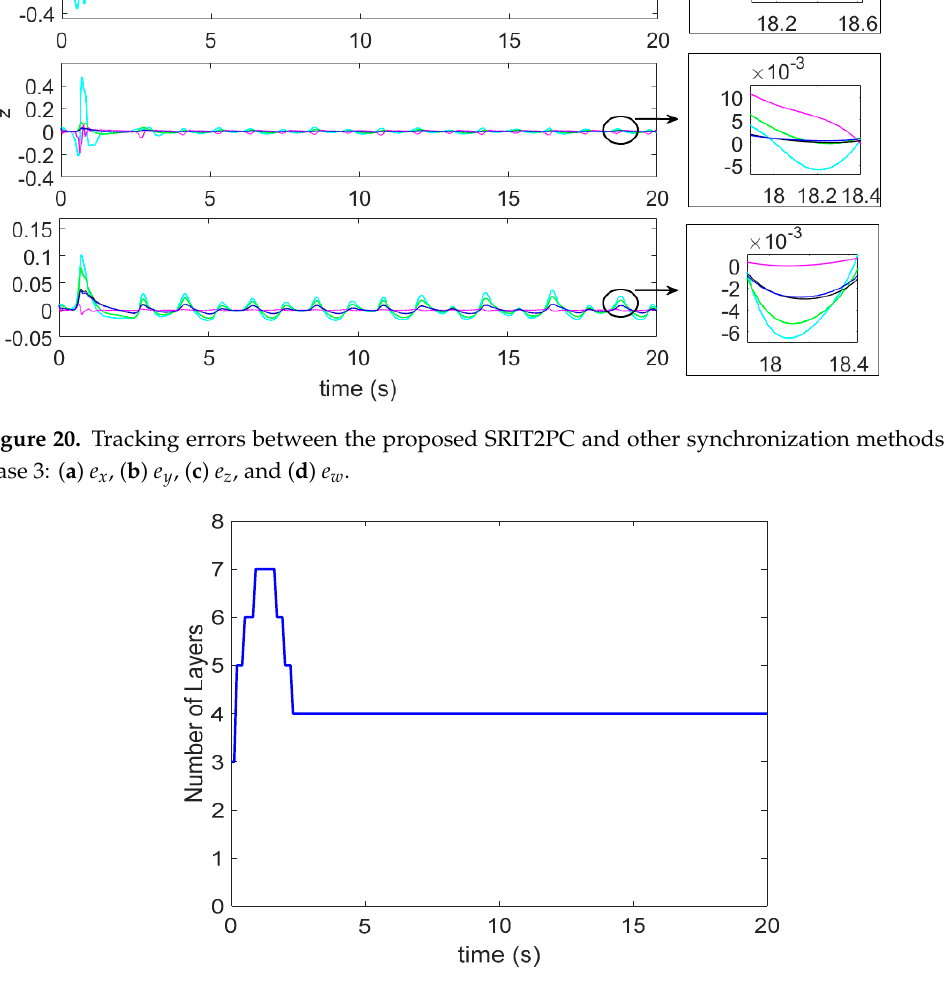
Figure 21. Number of layers using self-evolving algorithm for Case 3.